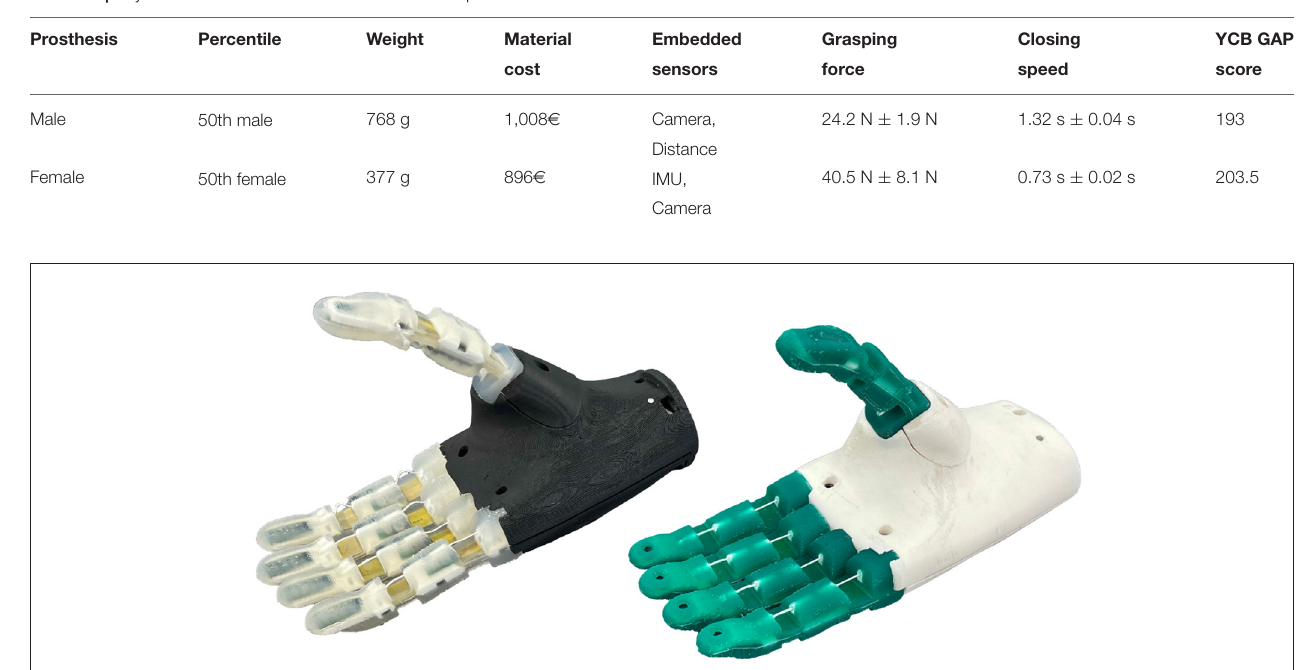
FIGURE 11 | The KIT sensorized soft hand (left) and KIT finger-vision soft hand (right) inspired by the prosthetic hand